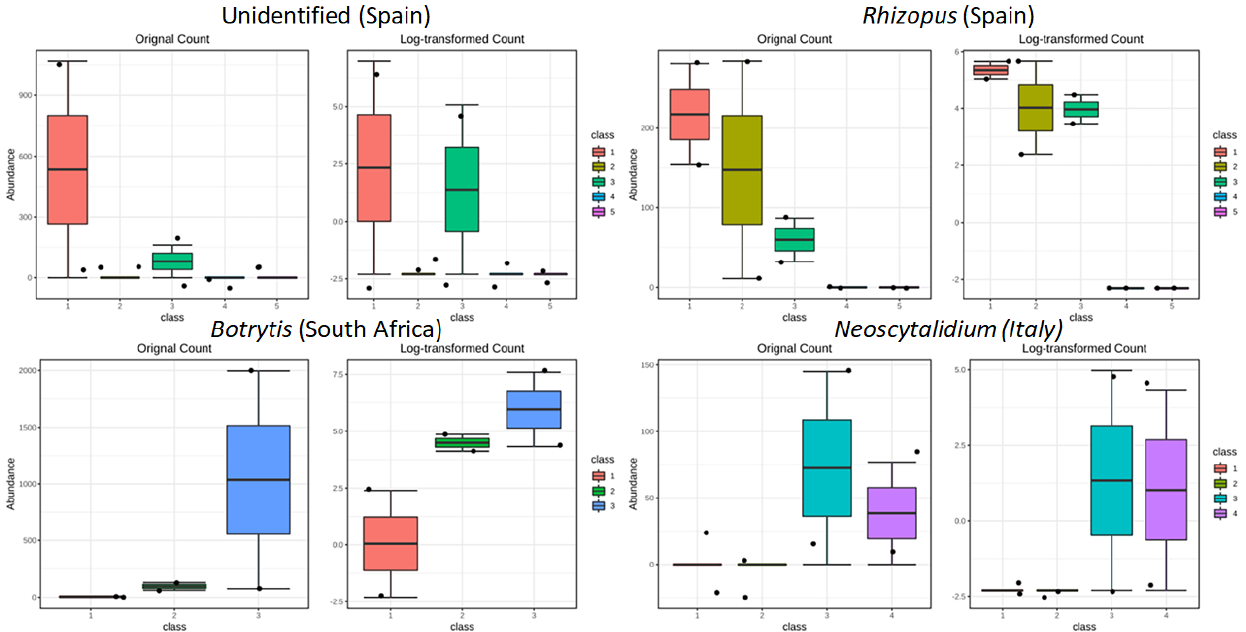
Figure 6. Statistically different genus abundance among fields: Spain, Rhizopus and an unidentified genus ; South Africa, Botrytis ; Italy, Neoscytalidium . Class, on the x − axis, indicates the field where the samples were collected (Table A1). Data analysis was performed with R package DESeq2. Statistically differentiated genus abundance corresponds to a q − value cutoff of 0.05.